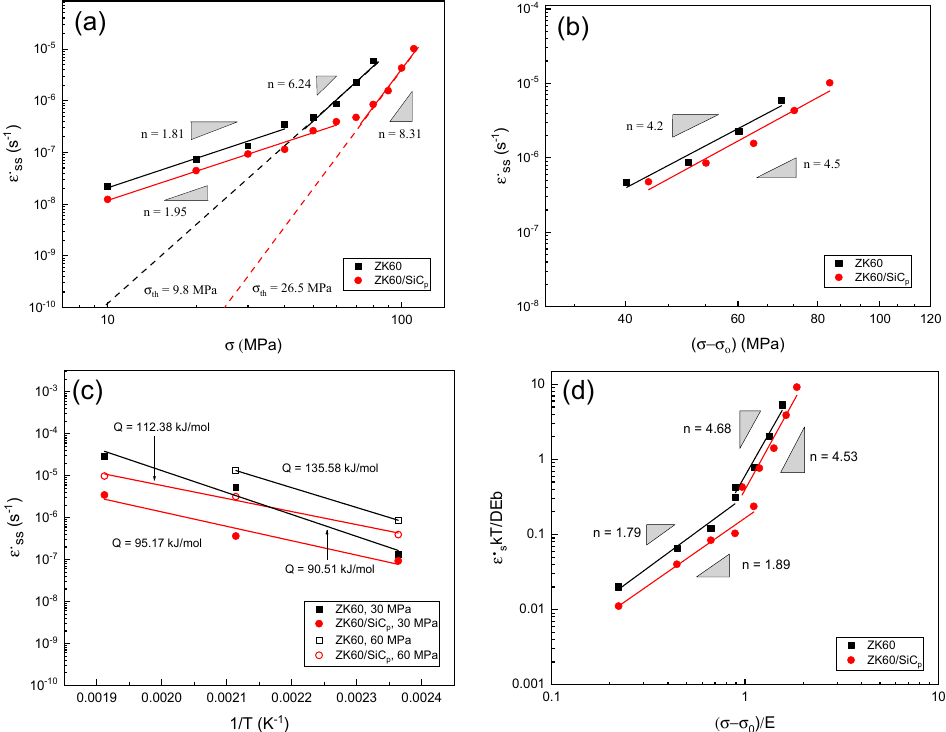
Figure 5. Minimum creep rate changes in unreinforced alloy and ZK60/SiC p composite in terms of: ( a ) stress and ( b ) effective stress, ( c ) Minimum creep rate changes in 1/T at 30 and 60 MPa for unreinforced alloy and ZK60/SiC p composite, and ( d ) Normalized minimum creep rate variations with normalized stress diffusion coefficient for unreinforced alloy and ZK60/SiC p composite .